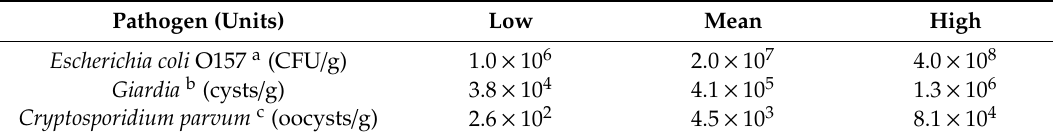
Table 1. Bather shedding pathogen concentrations.